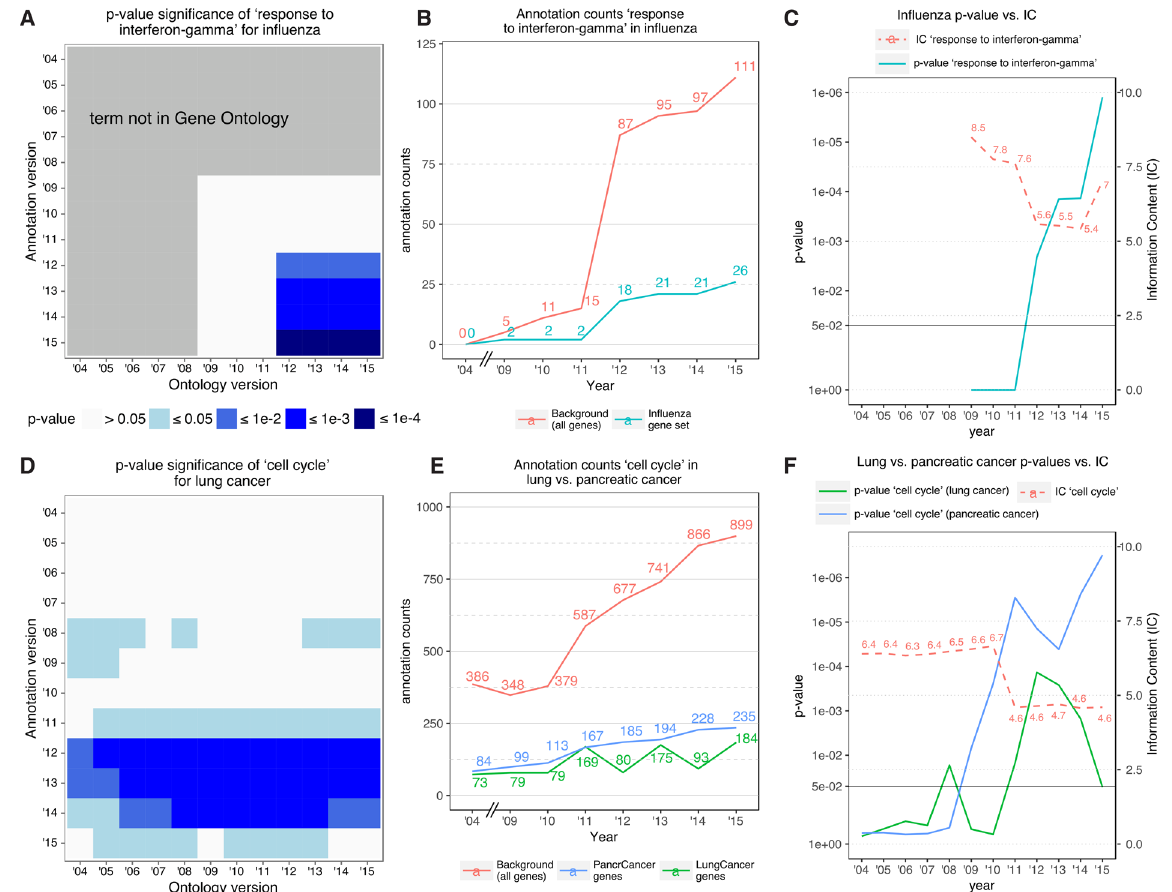
Figure 4. Effect of ontology and annotation version on consistency and significance of GO enrichment analysis results. ( A ) Effect in influenza for the GO term response to interferon-gamma . ( B ) Number of human genes annotated with the GO term response to interferon-gamma (including all child terms) in influenza gene set vs. background. ( C ) Comparison of enrichment p-value and information content (IC) developments with annual updates of GO and GO annotations (year of GO version = year of GO annotation version) for response to interferon-gamma in influenza. ( D ) GO term enrichment significance for cell cycle in non-small cell lung cancer (see Supplementary Figure 8 for pancreatic cancer). ( E ) Number of human genes annotated with the GO term cell cycle (including child terms) in pancreatic and non-small cell lung cancer gene sets vs. background (human genome). ( F ) Comparison of enrichment p-value and IC developments with annual updates of GO and GO annotations for cell cycle in pancreatic and non-small cell lung